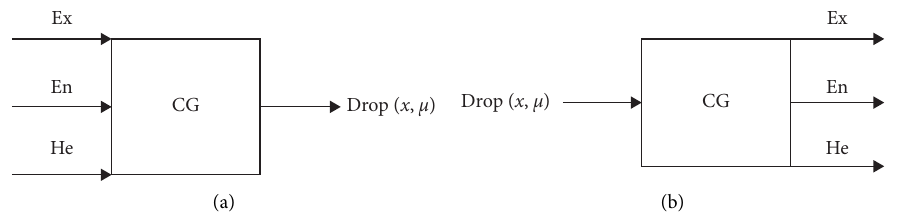
Figure 2: Cloud model generator. (a) Forward Cloud Generator and (b) Backward Cloud Generator.